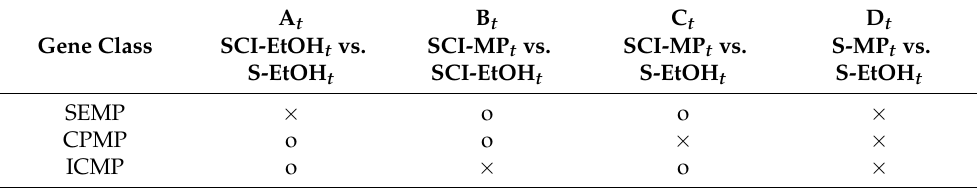
Table 2. Significancy table of three gene classes against four differentially expressed gene sets. A t B t C t D t Gene Class SCI-EtOH t vs. SCI-MP t vs. SCI-MP t vs. S-MP t vs. S-EtOH t SCI-EtOH t S-EtOH t S-EtOH t SEMP × o o × CPMP o o × × ICMP